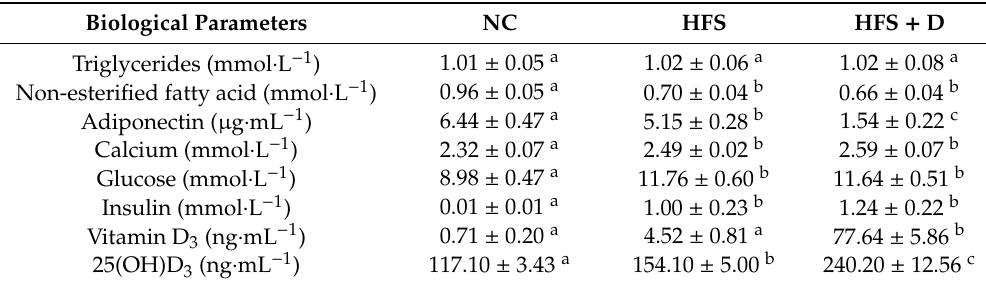
Table 1. E ff ect of vitamin D on mice biological